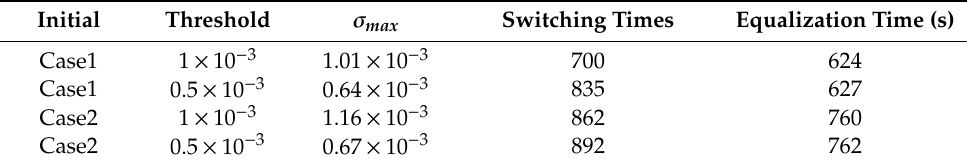
Table 6. Simulation results to verify the e ff ect of current sampling